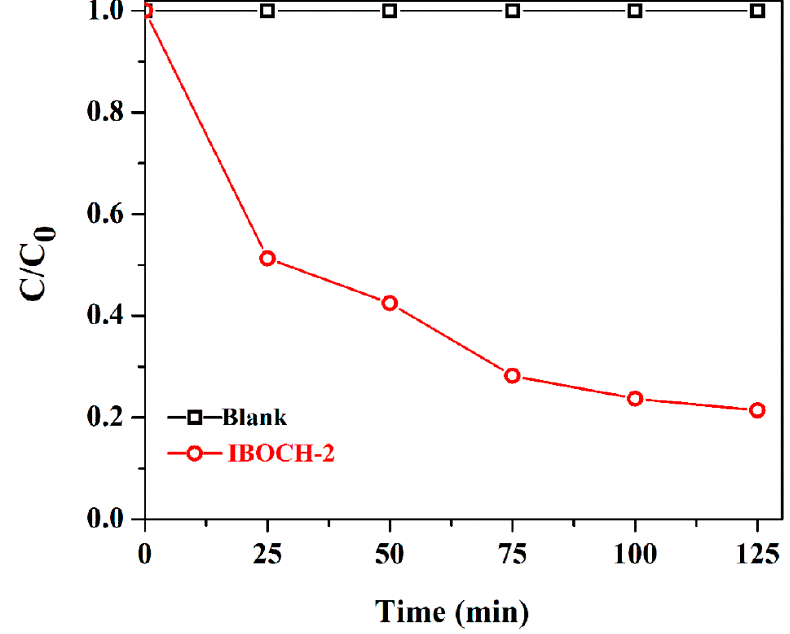
Figure 7. Photodegradation of TC by the IBOCH-2 p–n heterojunction under visible light.